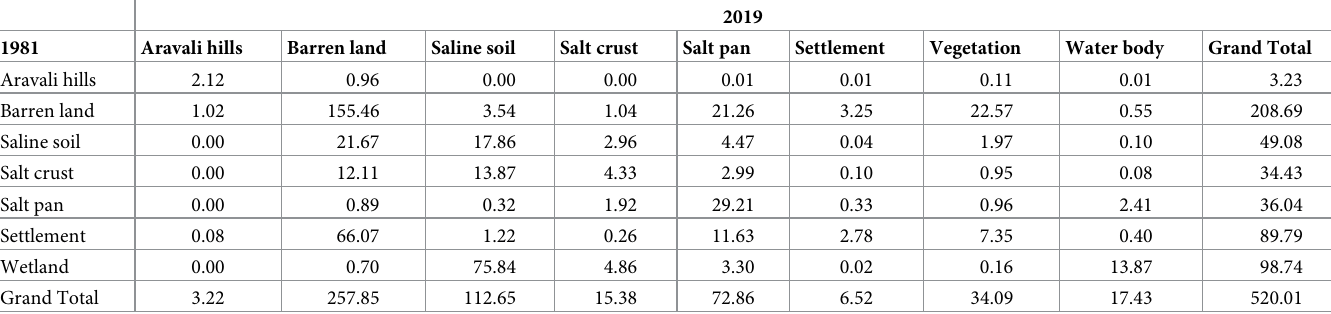
Table 4. LULC transition matrix from